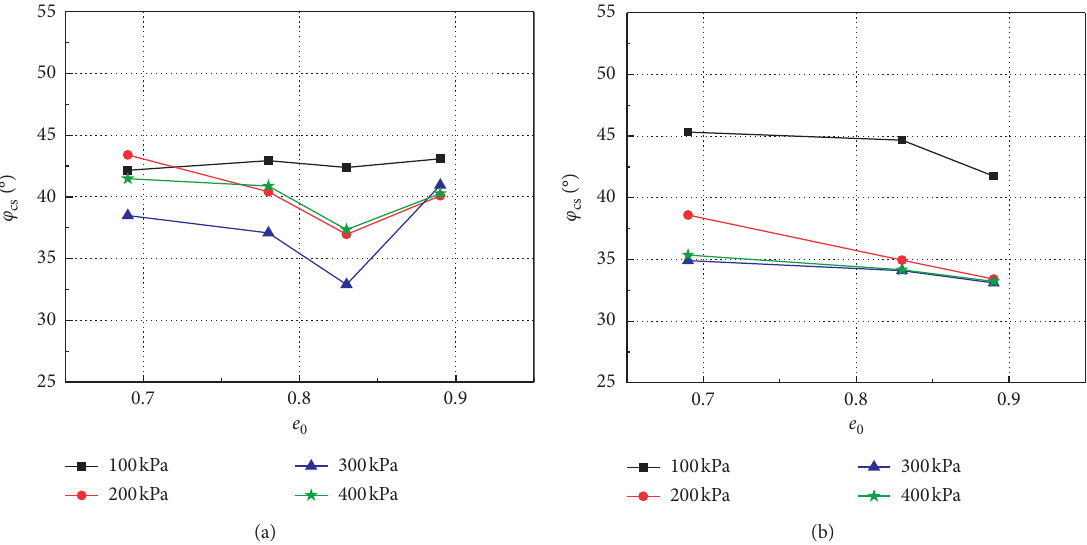
Figure 15: Relationship between φ cs and e 0: (a) coral mud and (b) Taizhou soil.